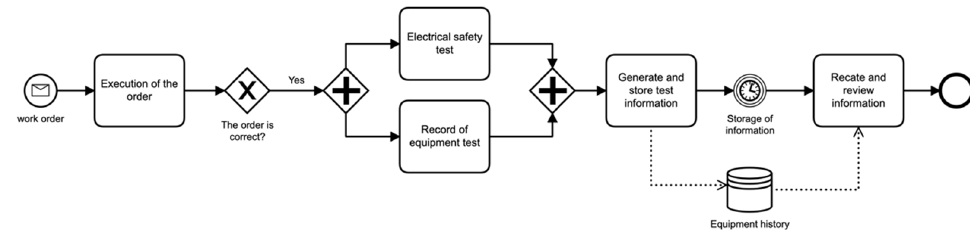
Figure 1. Process of storage of a work order.